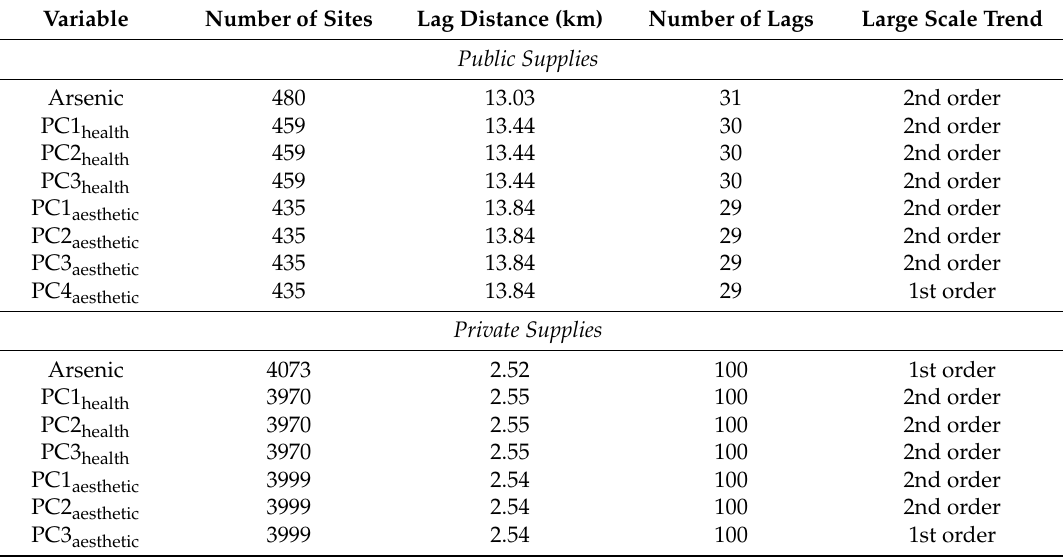
Table 5. Summary of parameters used as input for variogram models for ordinary and universal